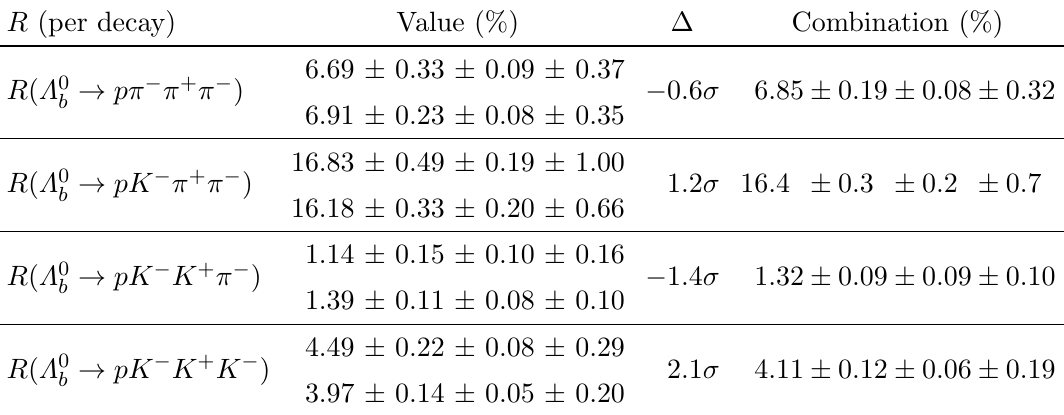
Table 5 . Measurements of the R ratio from the ((cid:12)rst row) 2011 and the (second row) 2012 data samples for (cid:3) 0 decay modes expressed in percent as well as their combination. The three uncer- b tainties are statistical, systematic related to the (cid:12)t model and systematic related to the e(cid:14)ciency, respectively. The consistency of the two determinations for each year, denoted (cid:1), is quanti(cid:12)ed as the ratio of the signed di(cid:11)erence of the central values over the quadratic sum of the related uncer-